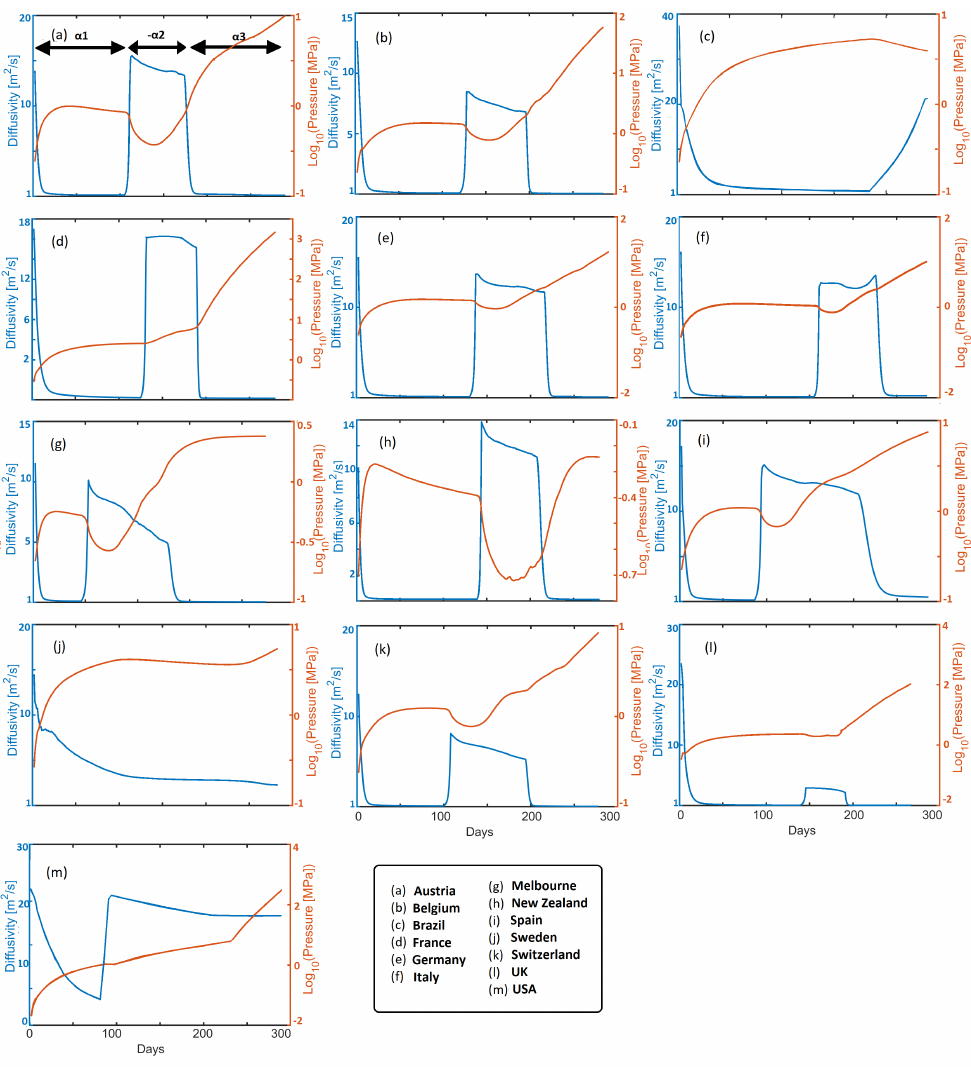
Figure 4. Modeled diffusivity (blue) and pressure time histories (orange) for each individual country (and Melbourne) showing the hydro-dynamical response to mitigation measures. For reference, the hydrogeological properties of beach sand and water is roughly 15 m 2 s − 1